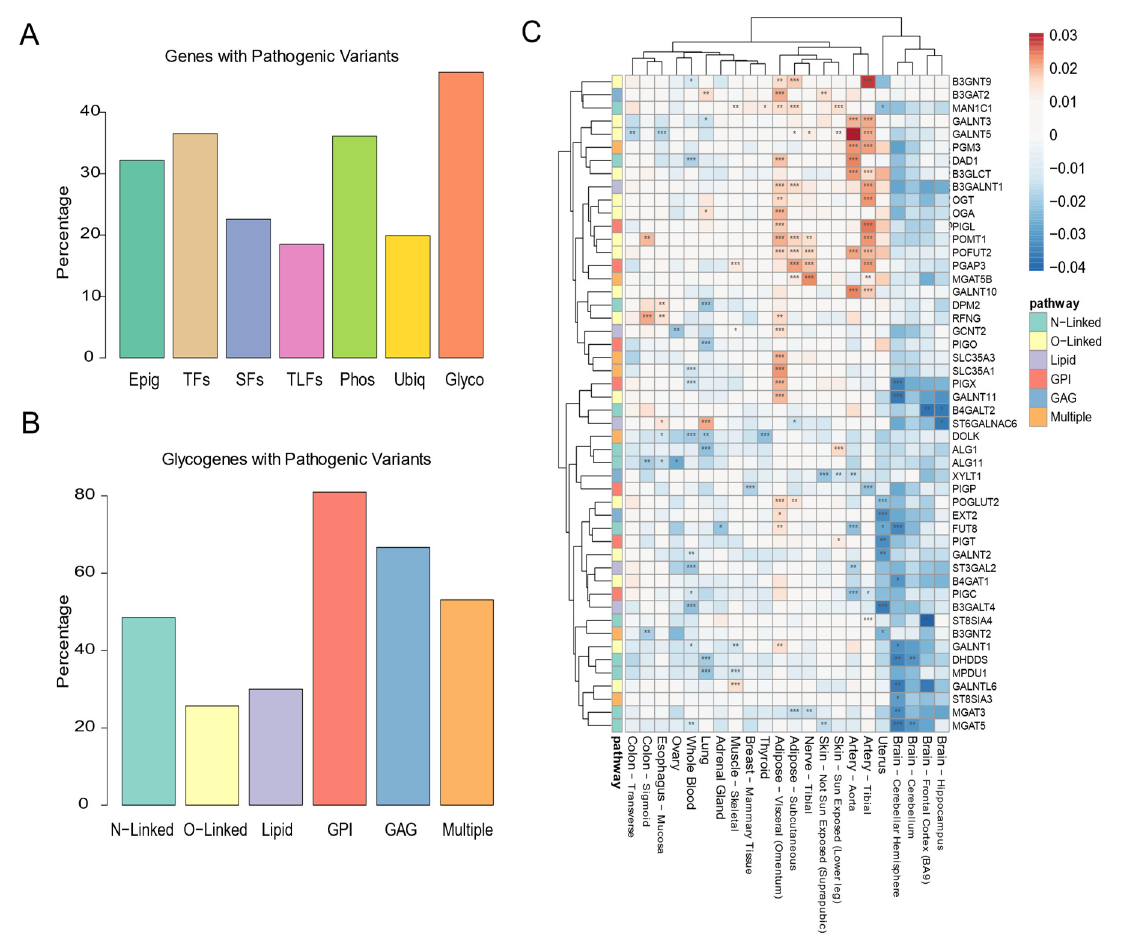
Figure 4. Glycosylation machinery is important in human health. ( A ) Bar plot of the percentage of genes associated with pathogenic variants in Clinvar, according to their gene class. ( B ) Bar plot of the percentage of glycosylation factors associated with pathogenic variants in Clinvar, according to their glycosylation subclass. ( C ) Heatmap representation of glycosylation factors whose expression changes in GTEX ageing tissues. Heatmap colors represent the coefficients from a linear model associating age with gene expression, in a given tissue (*: p < 0.05; **: p < 0.01; ***: p < 0.001). Red indicates higher and blue lower expression with ageing.